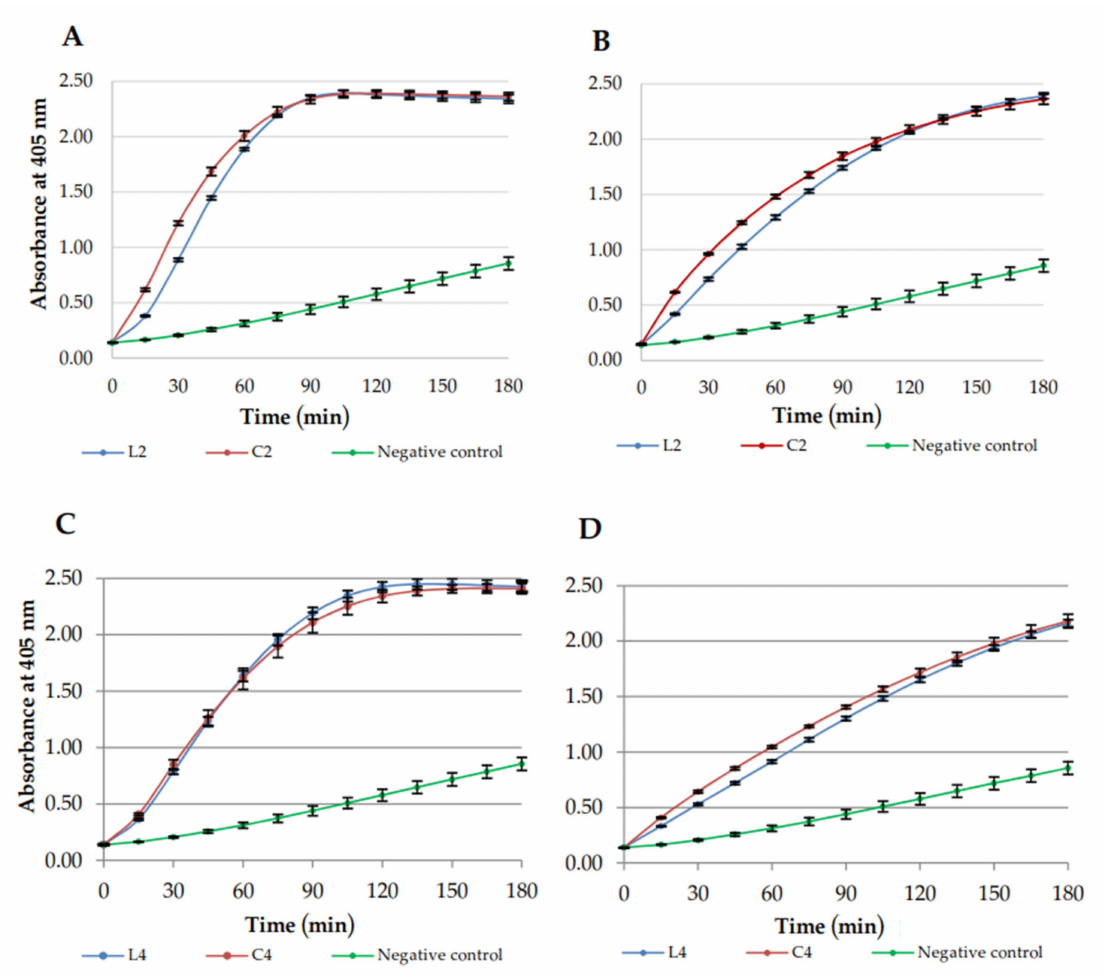
Figure 5. Inner membrane (IM) permeabilization kinetics. ( A ) L2 and C2 , 4 µ g / mL; ( B ) L2 and C2 , 8 µ g / mL; ( C ) L4 and C4 , 4 µ g / mL; and ( D ) L4 and C4 , 8 µ g /